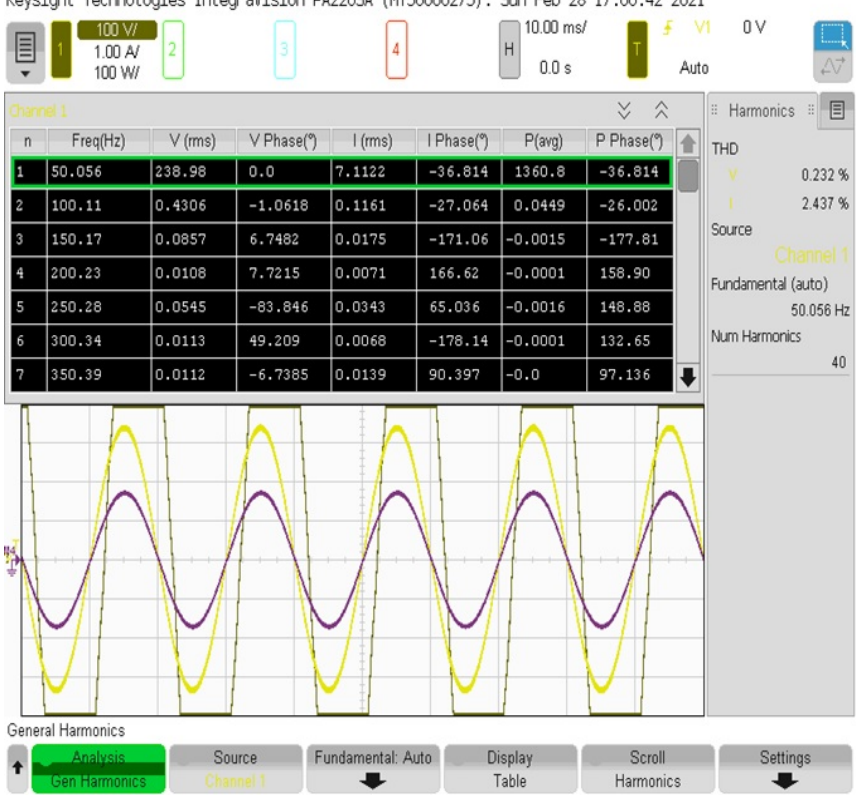
Figure 14. Voltage sag conditions in grid connected to induction motor under loaded conditions.